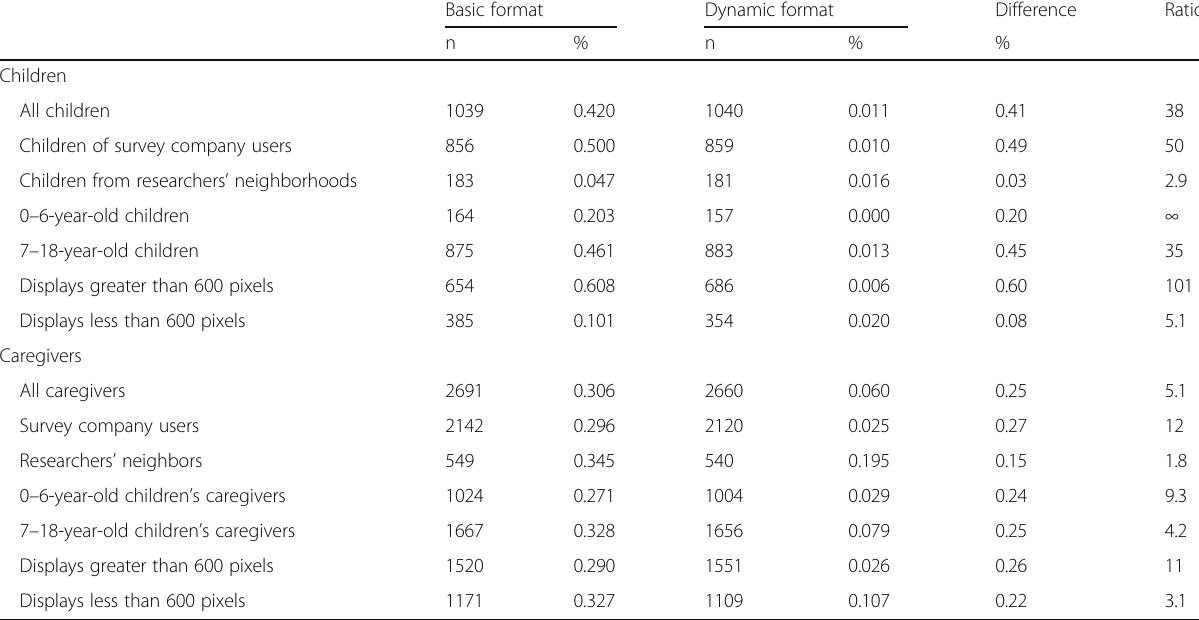
Table 2 Item non-response rate of two formats of the